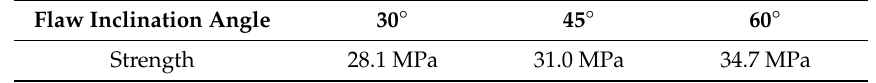
Table 3. Average dynamic compressive strength with respect to the initial flaw inclination